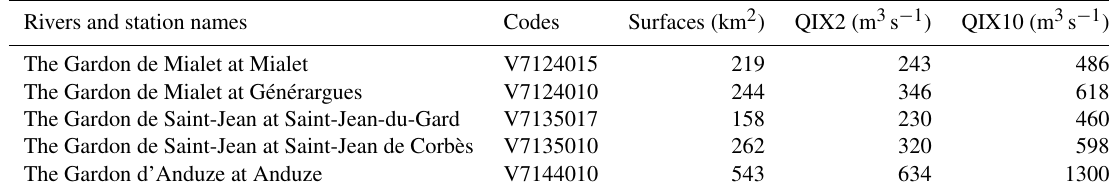
Table 1. Characteristics of the five gauging stations on the Gardon watershed. QIX2 and QIX10 stand for the quantile discharge, respectively, for 2- and 10-year return periods.